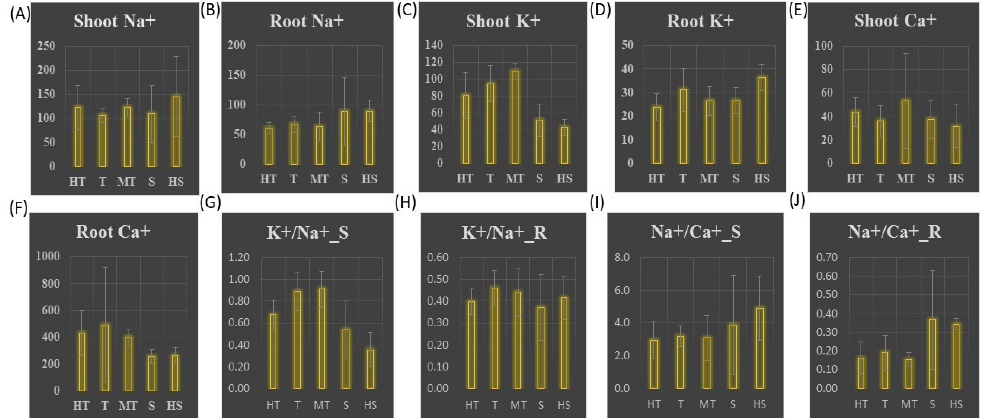
Figure 3. Mean ionic content of selected 20 wheat genotypes clustered according to their salt tolerance index ( n = 4). Cluster 1 = HS: highly susceptible (<20%); Cluster 2 = S: susceptible (20–40%); Cluster 3 = MT: moderately tolerant (40–60%); Cluster 4 = T: tolerant (60–80%); Cluster 5 = HT: highly tolerant (80–100%).